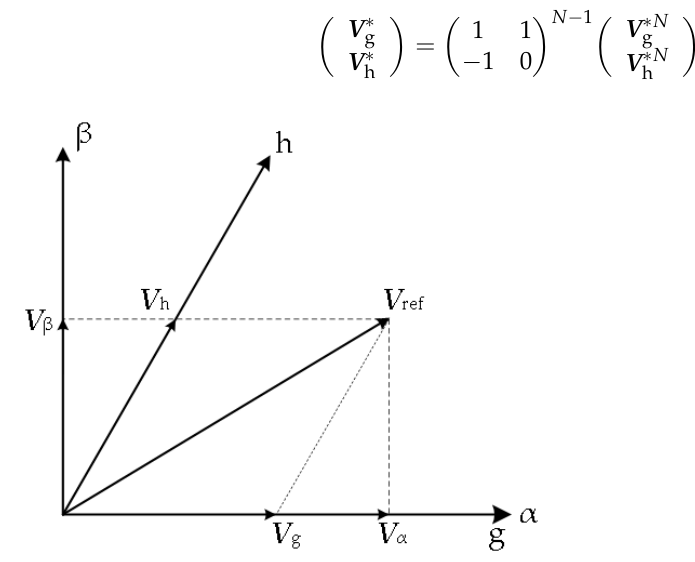
Figure 4. Axis transformation from the α - β axis to the g-h axis.